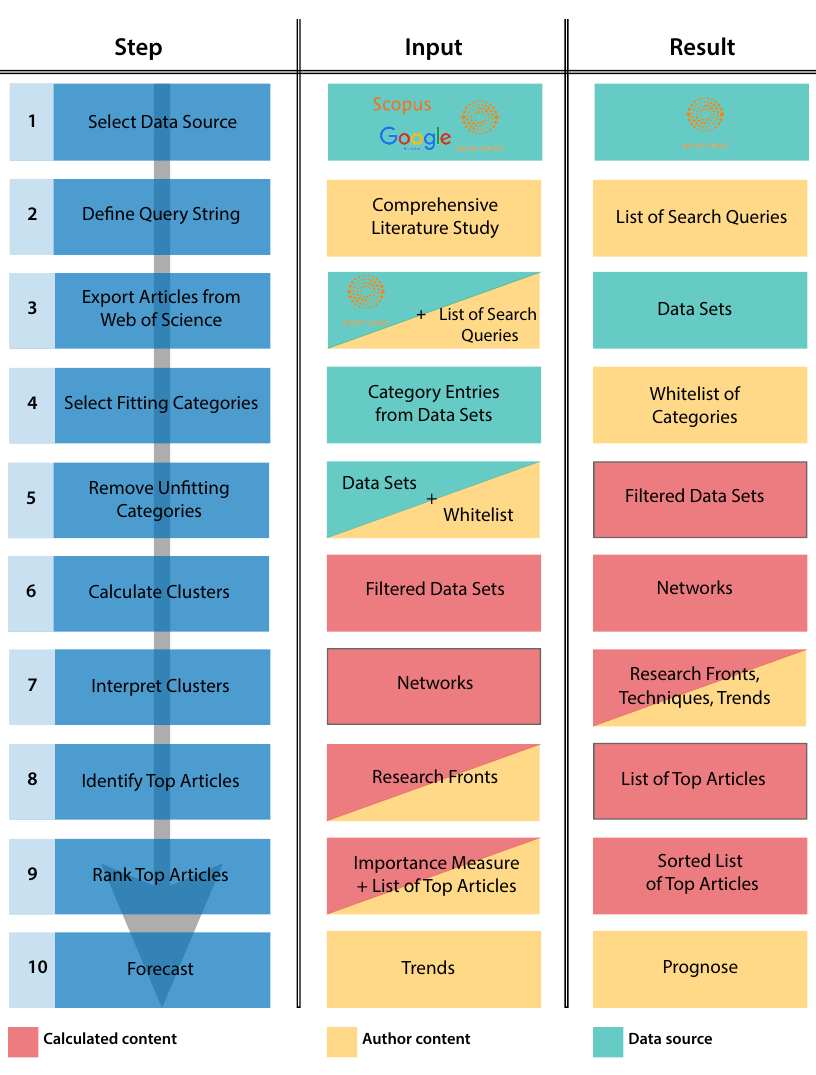
Figure 1. Workflow of a Bibliometric